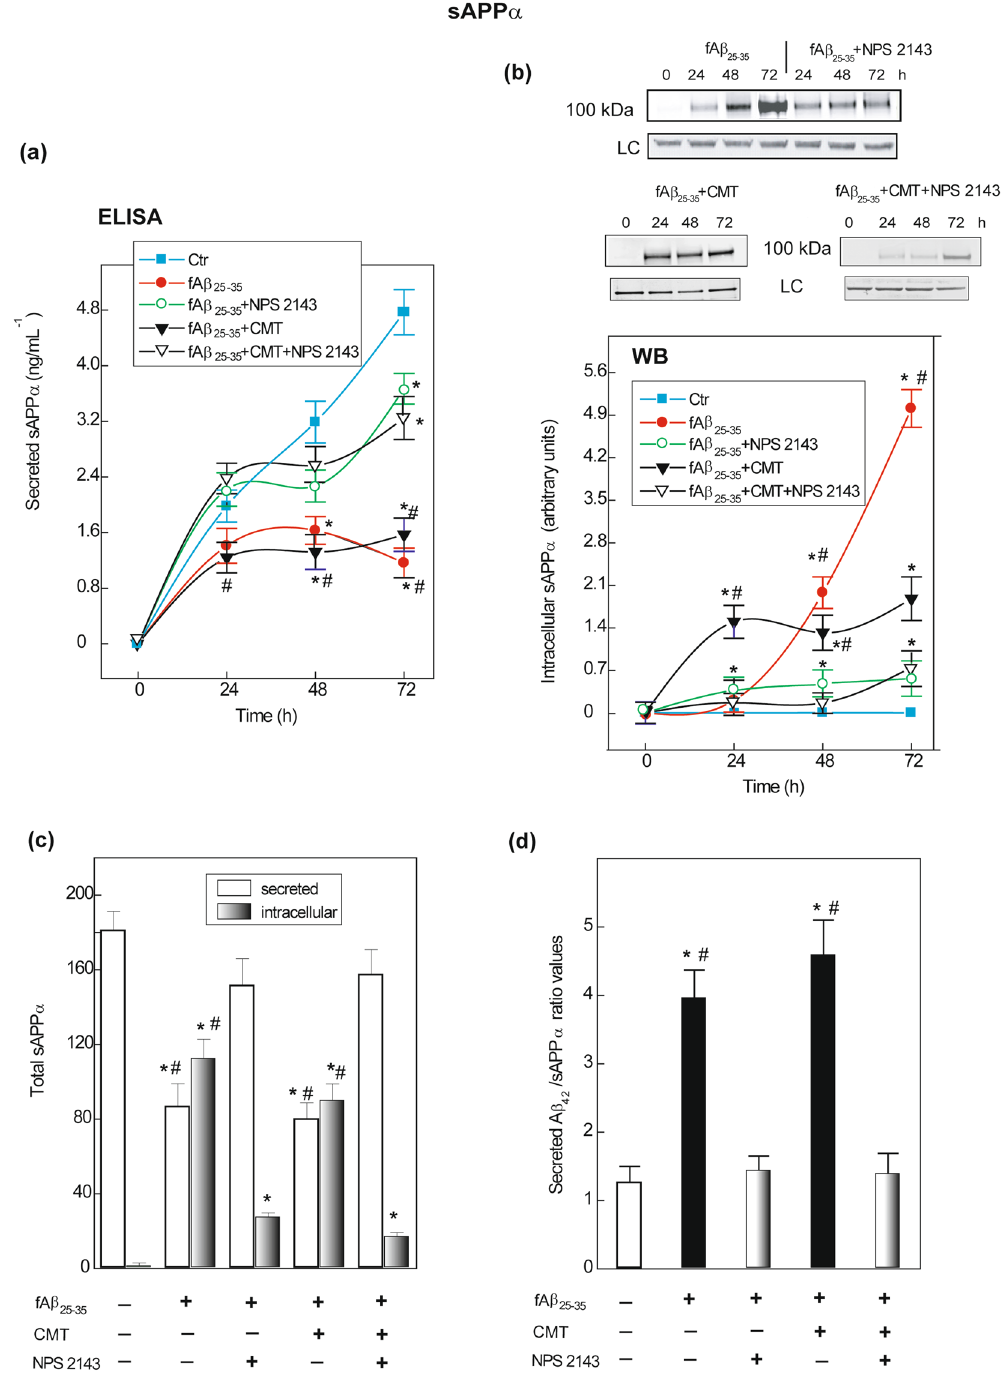
Figure 2. Changes in human astrocytes intracellularly accumulated and extracellularly shed amounts of sAPP α according to treatments. (a ) Cumulative curves of sAPP α shed into the medium by astrocytes as affected by treatments. Points on the curves are means ± SEM of 5 independent experiments. One-way ANOVA analysis of each complete data set: fA β 25–35 : F = 80.877, P < 0.001; fA β 25–35 + NPS 2143: F = 35.365, P < 0.001; fA β 25–35 + CMT: F = 50.882, P < 0.001; fA β 25–35 + CMT + NPS 2143: F = 34.261, P < 0.001. Bonferroni t-test : comparisons of each treated group versus 0-h group (controls): * P < 0.05; pair-wise comparisons between corresponding treatments ± NPS 2143 at each time point: # P < 0.05. (b ) Top . Typical immunoblot revealing the changes in intracellularly accumulated sAPP α according to treatments versus controls (0-h). LC, loading control. Blots have been cropped to size for clarity. Bottom . Densitometric evaluations of intracellular sAPP α bands. Points on the curves are means ± SEM of 3 independent experiments, with 0-h values normalized as 1.0. One-way ANOVA analysis of each complete data set: fA β 25–35 ± NPS 2143: F = 280.483, P < 0.001; fA β 25–35 + CMT ± NPS2143: F = 134.239, P < 0.001. Bonferroni t-test : comparisons of each treated group versus 0-h group (controls): * P < 0.05; pair-wise comparisons between corresponding treatments ±